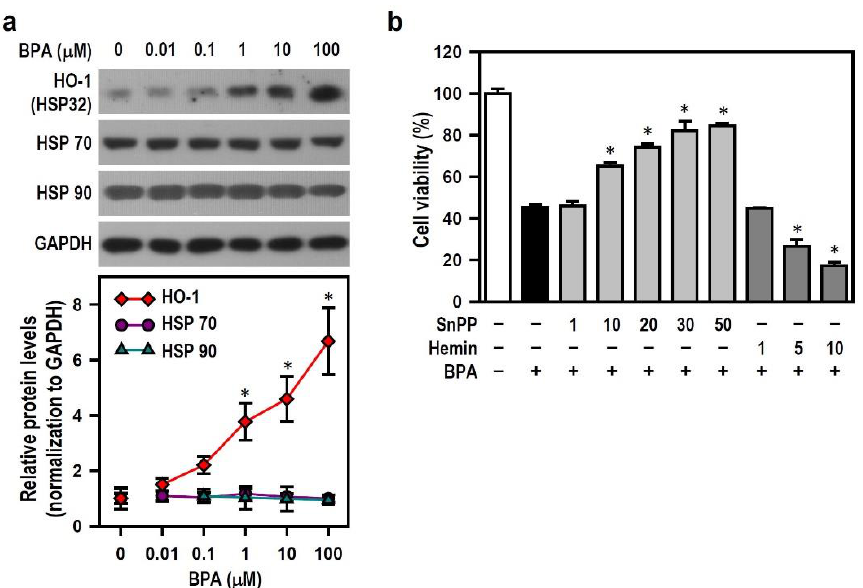
Figure 5. BPA selectively induces the production of heme oxygenase (HO)-1 but not HSP70 and HSP90, leading to the N2a cell survival decline. ( a ) Cultures were treated with different BPA concentrations for 24 h, and untreated culture (0 µ M BPA) was regarded as the control group. HO-1, HSP70 and HSP90 levels were detected using Western blots. A line plot shows the relative quantitation data of these HSPs. Each point represents the mean ± SEM ( n = 4). * p < 0.05 vs. control group. ( b ) Cultures were exposed to various concentrations ( µ M) of HO-1-related pharmacological agents, hemin chloride (Hemin), or tin protoporphyrin IX (SnPP), for 30 min before being treated with 100 µ M BPA for 24 h. Cell viability was assessed by MTT reduction assay. A bar plot shows the survival percent relative to the untreated control group (assigned a value of 100%). Data are represented as mean ± SEM ( n = 4, triplicate). * p < 0.05 vs. BPA